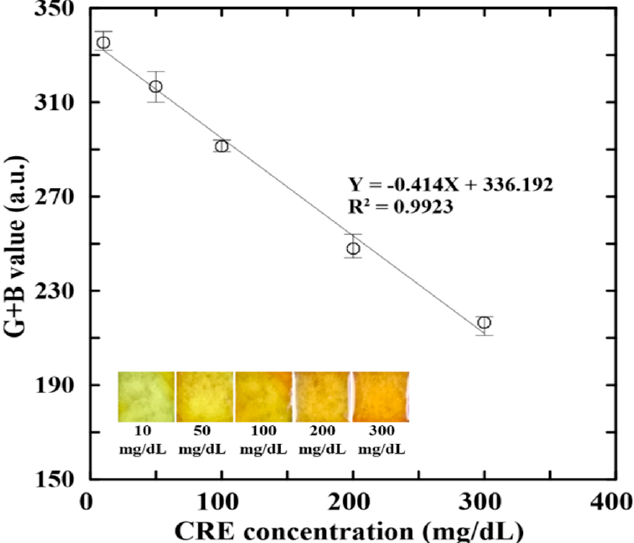
Figure 6. Variation of G + B intensity value with CRE concentration.